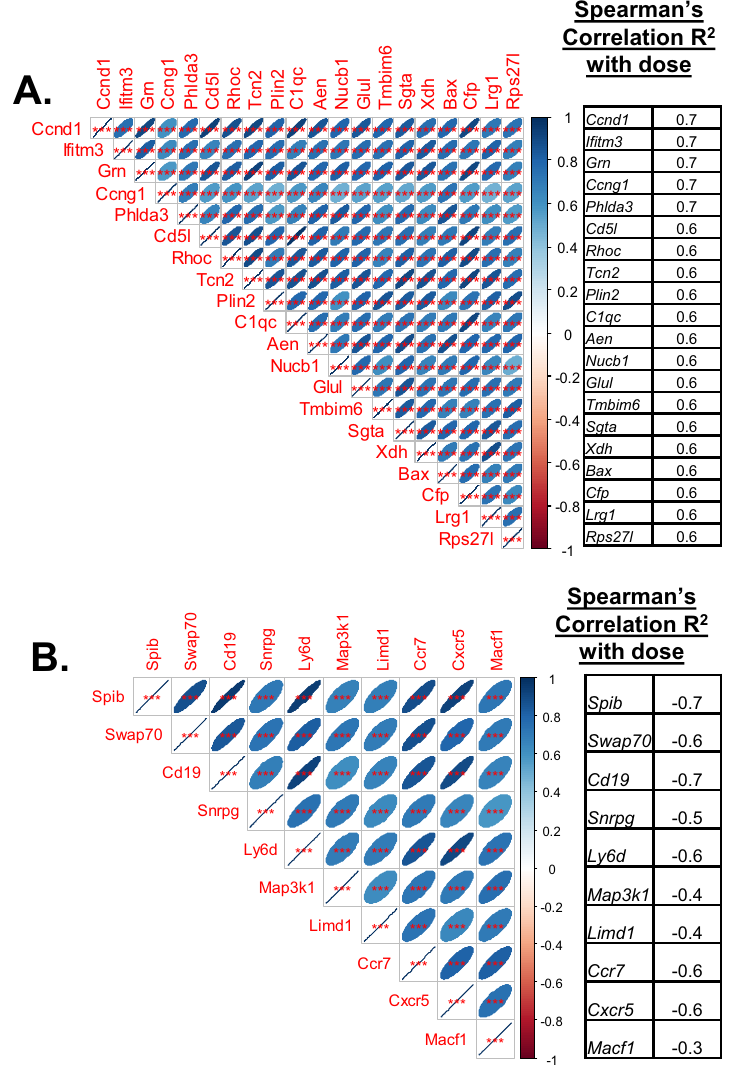
Figure 1. Correlation matrices of genes from the microarray meta-analysis that correlate with dose. ( A ) Genes that are positively correlated with dose, and ( B ) Genes that are negatively correlated with dose. Shown here in the matrix are pairwise correlations with each other. The size of the oval blue area indicates the correlation level, a broad oval indicates lower correlation, and the narrower oval indicates higher correlation (as indicated in the color gradient key). The table on the side shows the genes as listed and the correlation R 2 values with dose from the microarray analyses (ranging from 0.6 to 0.7 for positive correlation and − 0.3 to − 0.7 for negative correlation). All genes in each group are highly correlated with each other indicating that the patterns are highly similar in both the up and down regulated gene